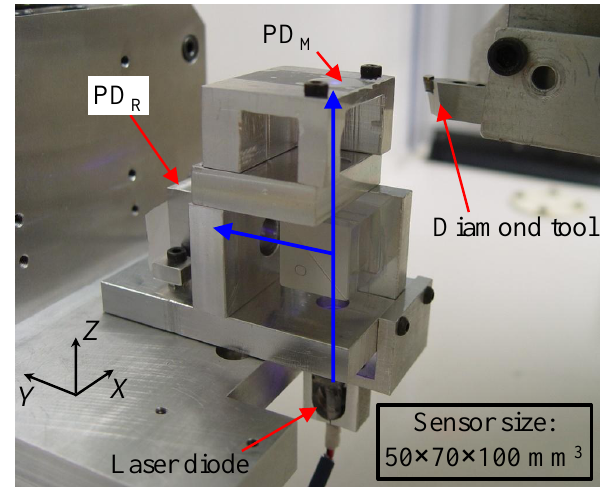
Figure 5. The developed micro optical probe mounted on the dia- mond cutting machine.